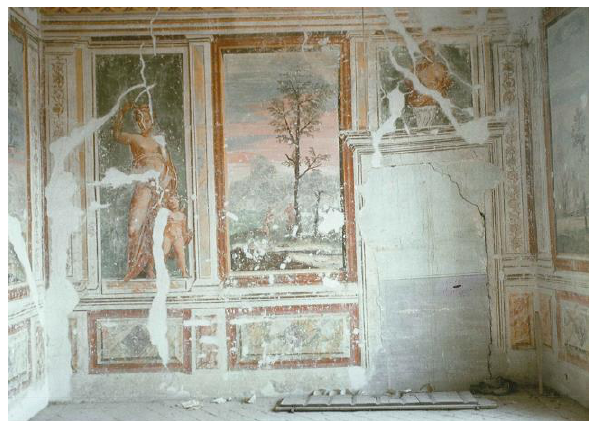
Figure 11: Crack pattern, room 28, 1990 (Private archive Federico